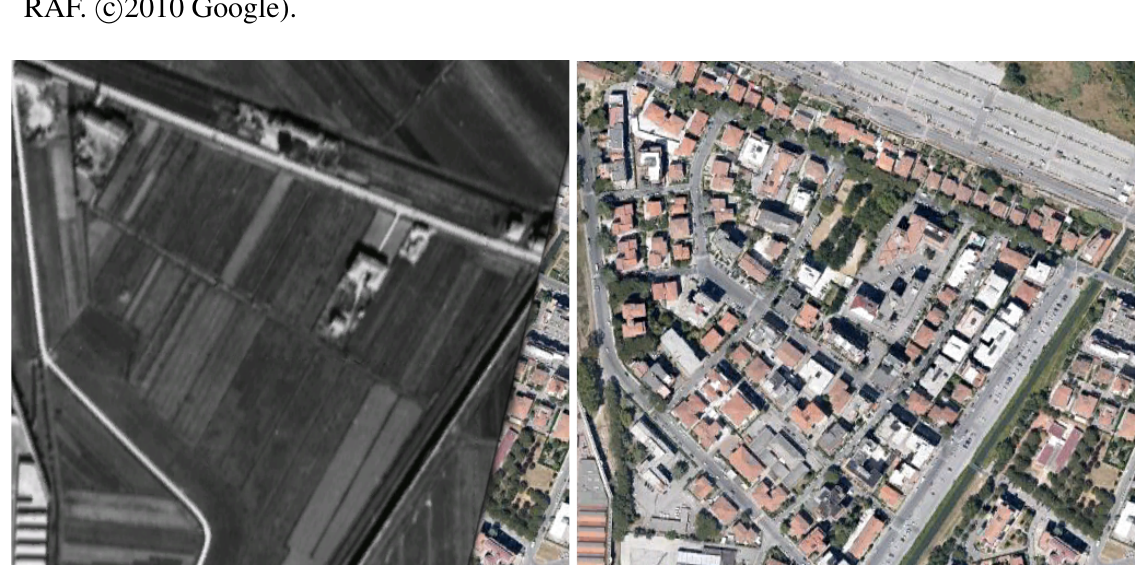
A closeup of the two maps that are blended together in Figure 10. New buildings now cover the old farmlands. ( c (cid:13) MiBAC-ICCD, Aerofototeca Nazionale, fondo RAF. c (cid:13) 2010